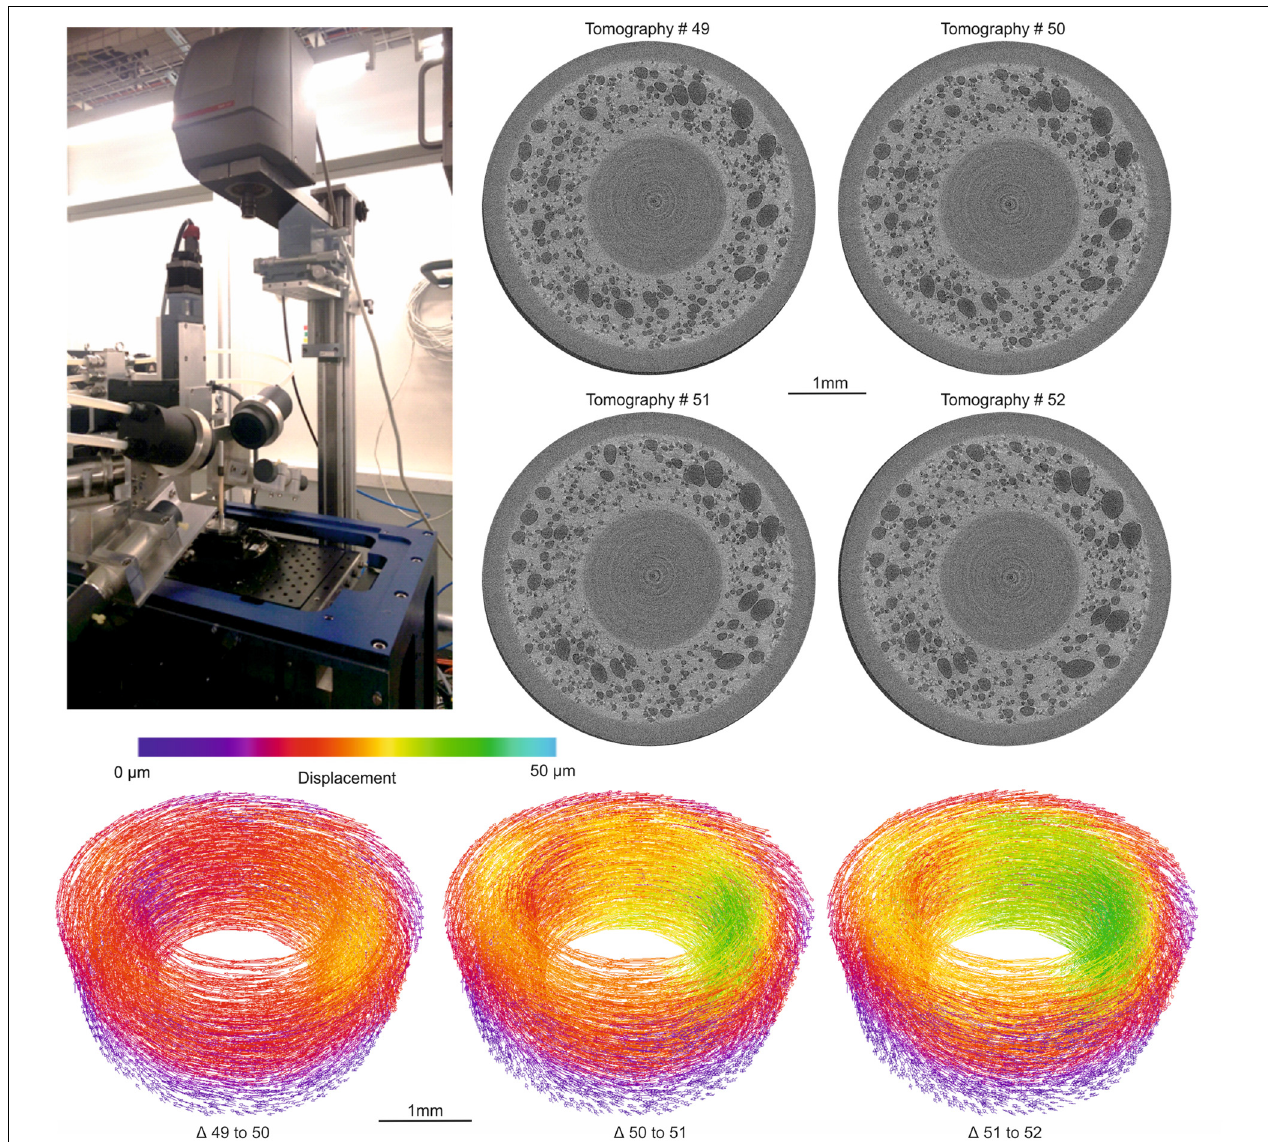
FIGURE 9 | Capturing deformation during rotational deformation. (TOP LEFT) Photograph showing the XRheo and the SLS laser system installed at TOMCAT (See Dobson et al., submitted for further details). (TOP RIGHT) Mid-section axial slices from four time steps through the measured volume (each image is 7 s apart). The cup and spindle are the mid gray cylindrical regions bounding the bubble-bearing melt (pale gray). Highly heterogeneous motion of bubbles (black) can be seen between all four images (especially in the bottom right quadrant). Data quality is sufficient to allow these displacements to be quantified using Digital Volume Correlation (BOTTOM), with the displacement vectors of the mesh centers shown colored by displacement